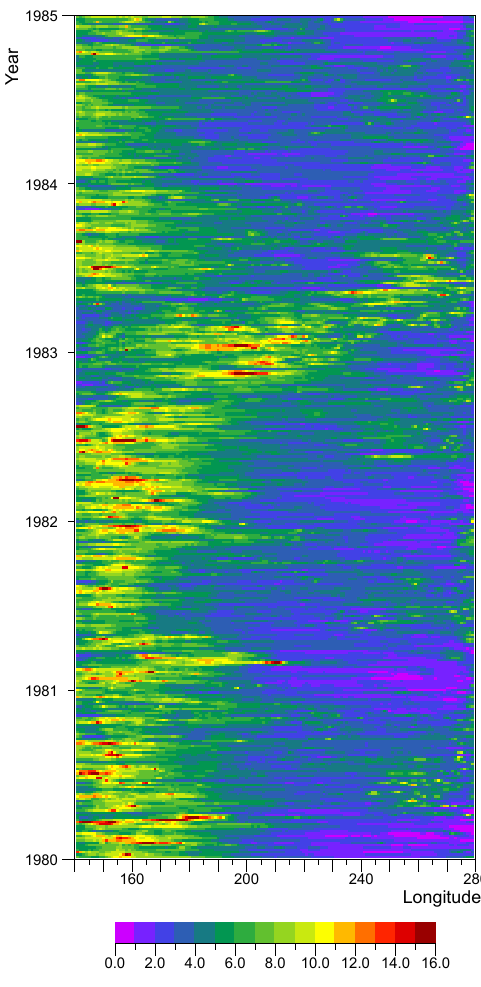
Figure 4. Precipitation (kgm − 2 day − 1 ) averaged between 12 ◦ S and 12 ◦ N.